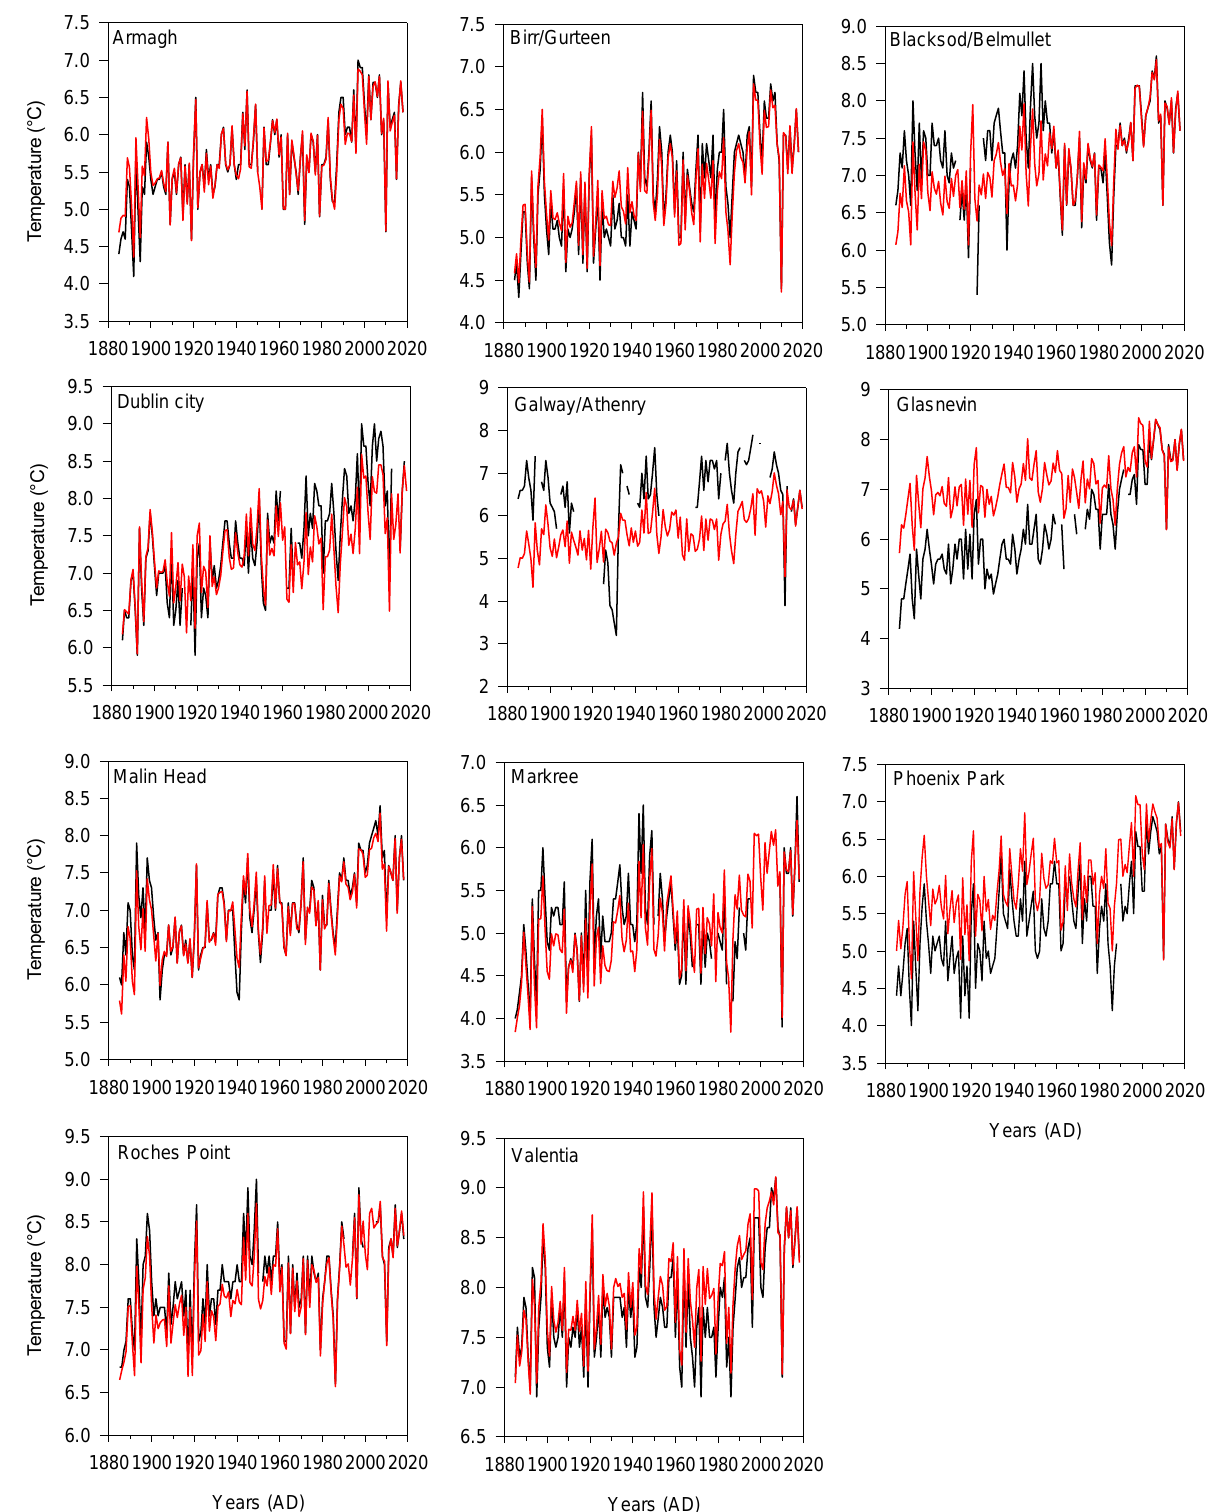
Figure 6. Quality-controlled (black) and homogenised (red) annual MIN series as part of the national network in 1885 – 2018.